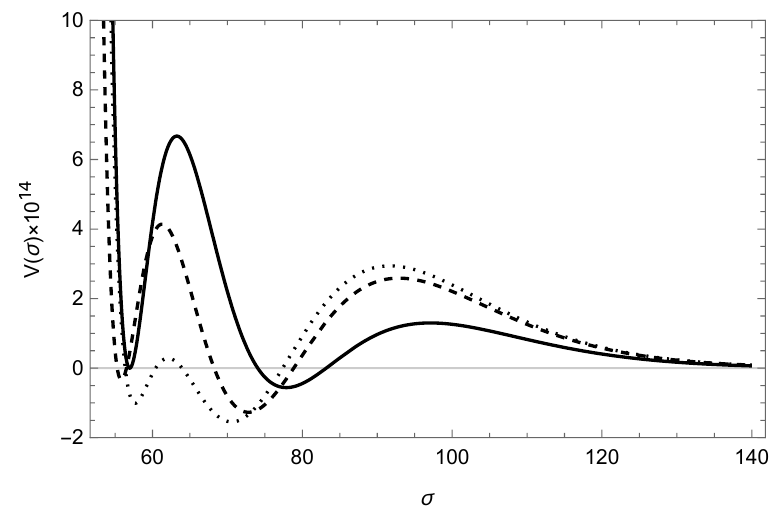
Figure 2 . The model with W 0 = 0 and N = 3 for A 2 = 0 . 98 , A 3 = − 1 . 05 , a 1 = 2 π/ 100 , a 2 = 2 π/ 80 , a 3 = 2 π/ 70 and A 1 = − (1 + δ )( A 2 e ( a 1 − a 2 ) σ 0 + A 3 e ( a 3 − a 2 ) σ 0 ) with σ 0 given by equation (2.15). The thick line corresponds to δ = 0 , while δ = 0 . 007 and 0 . 013 corresponds to the dashed and dotted lines,